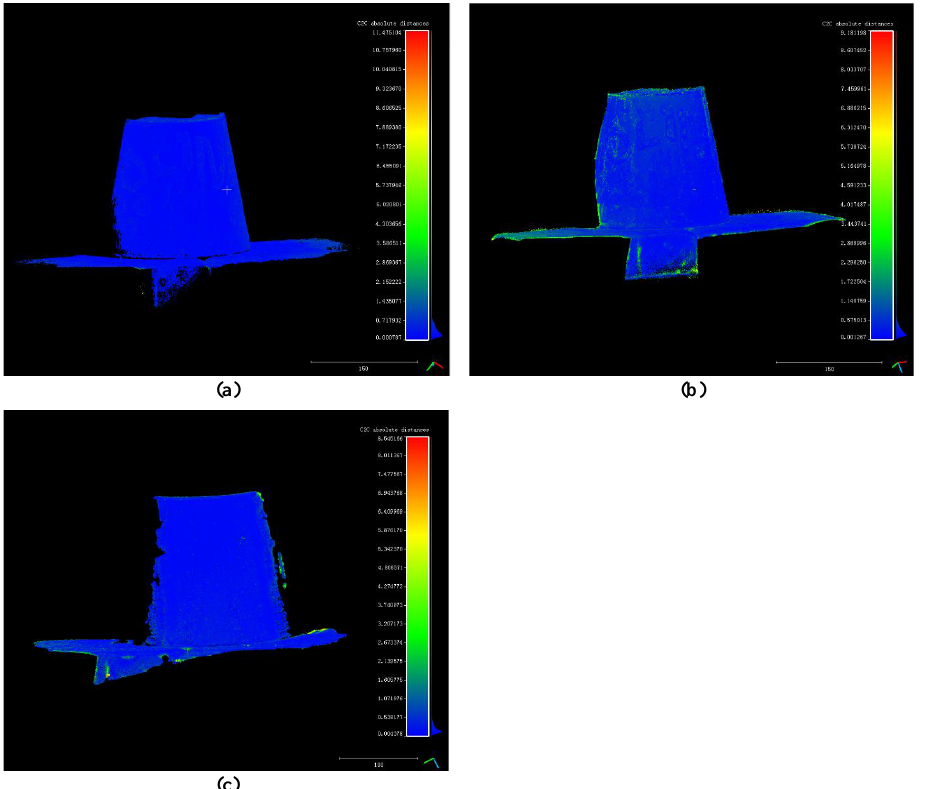
Figure 8. ( a ) Distance point cloud between the proposed method’s result and the standard point cloud; ( b ) Distance point cloud between openMVG + openMVS’s result and the standard point cloud; ( c ) Distance point cloud of MicMac and the standard point cloud.